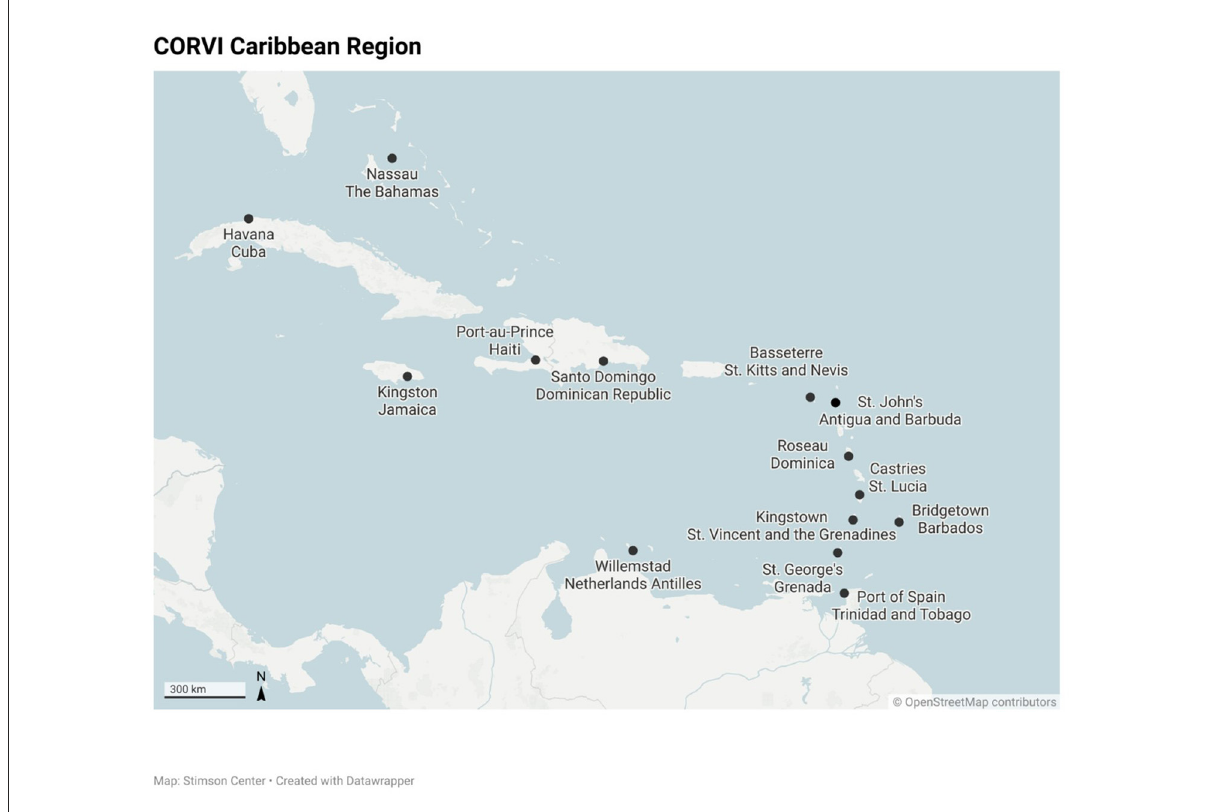
FIGURE5 Map of CORVI Caribbean region.